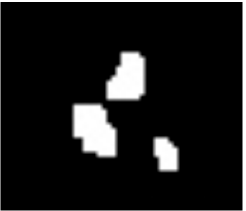
Figure 5. Threshold bagworms